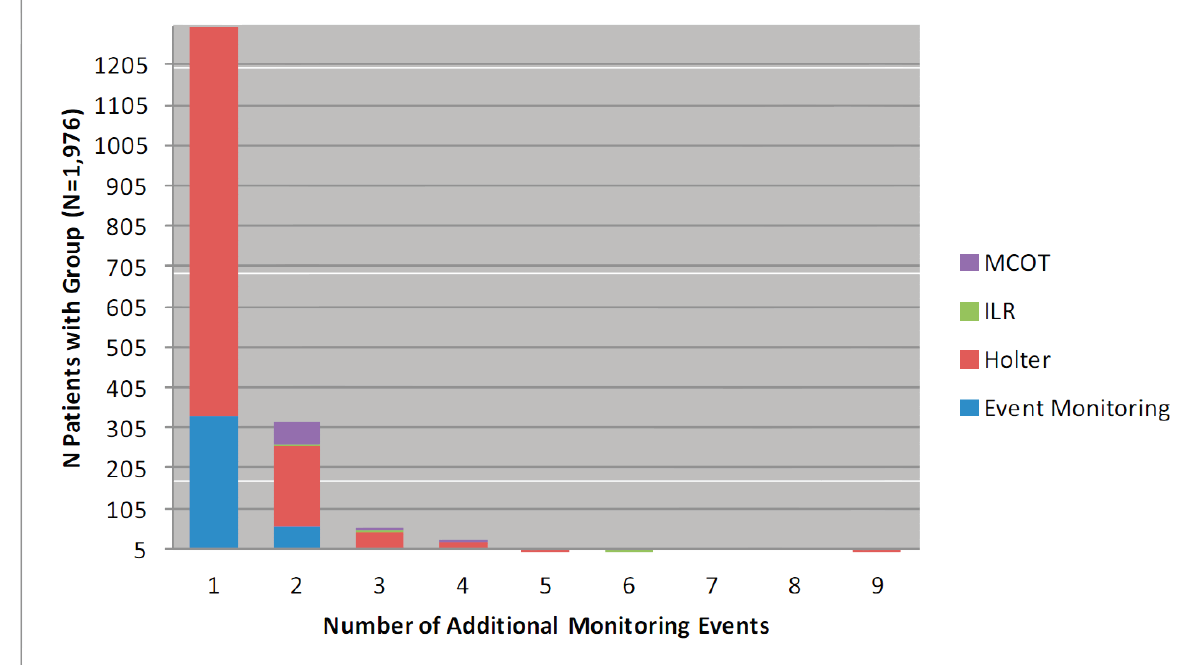
MCOT: Mobile Cardiac Outpatient Telemetry; ILR: implantable loop